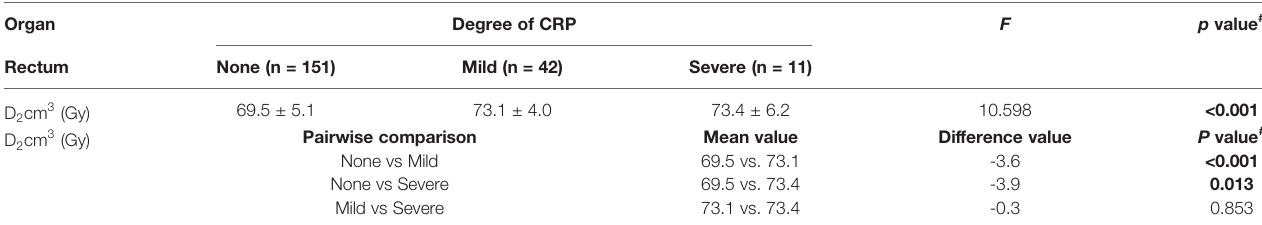
TABLE 3 | Relationship between degree of CRP and D 2 cm 3 of the rectum.